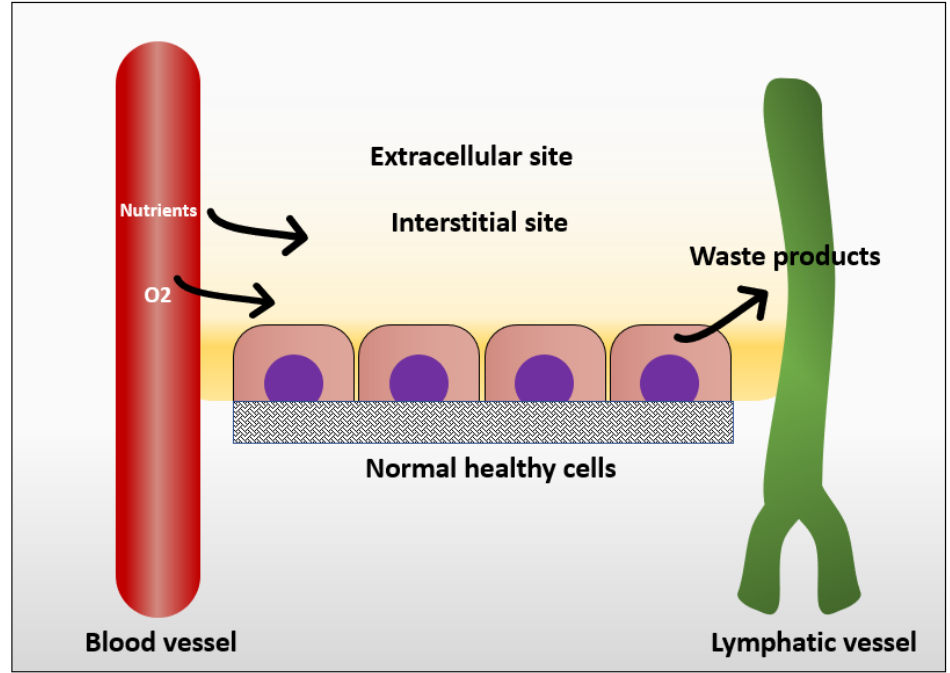
Figure 1. Mechanism in which normal cells get their nutrients and excrete their wastes. Table 1. Different shear rate values in physiological and pathological conditions.